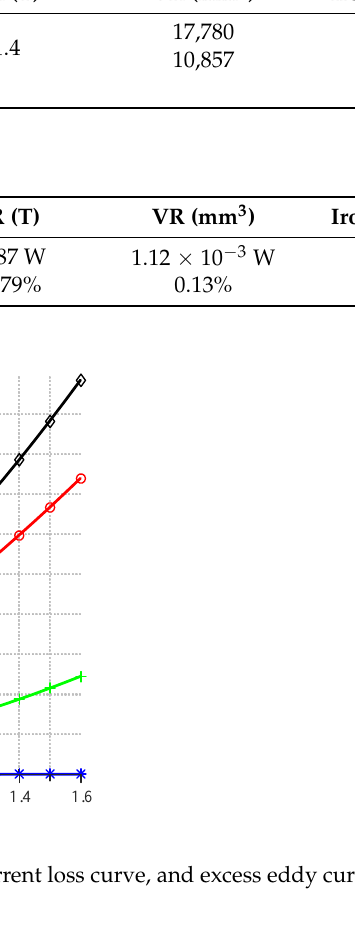
Table 6. Percentage of different iron loss types.